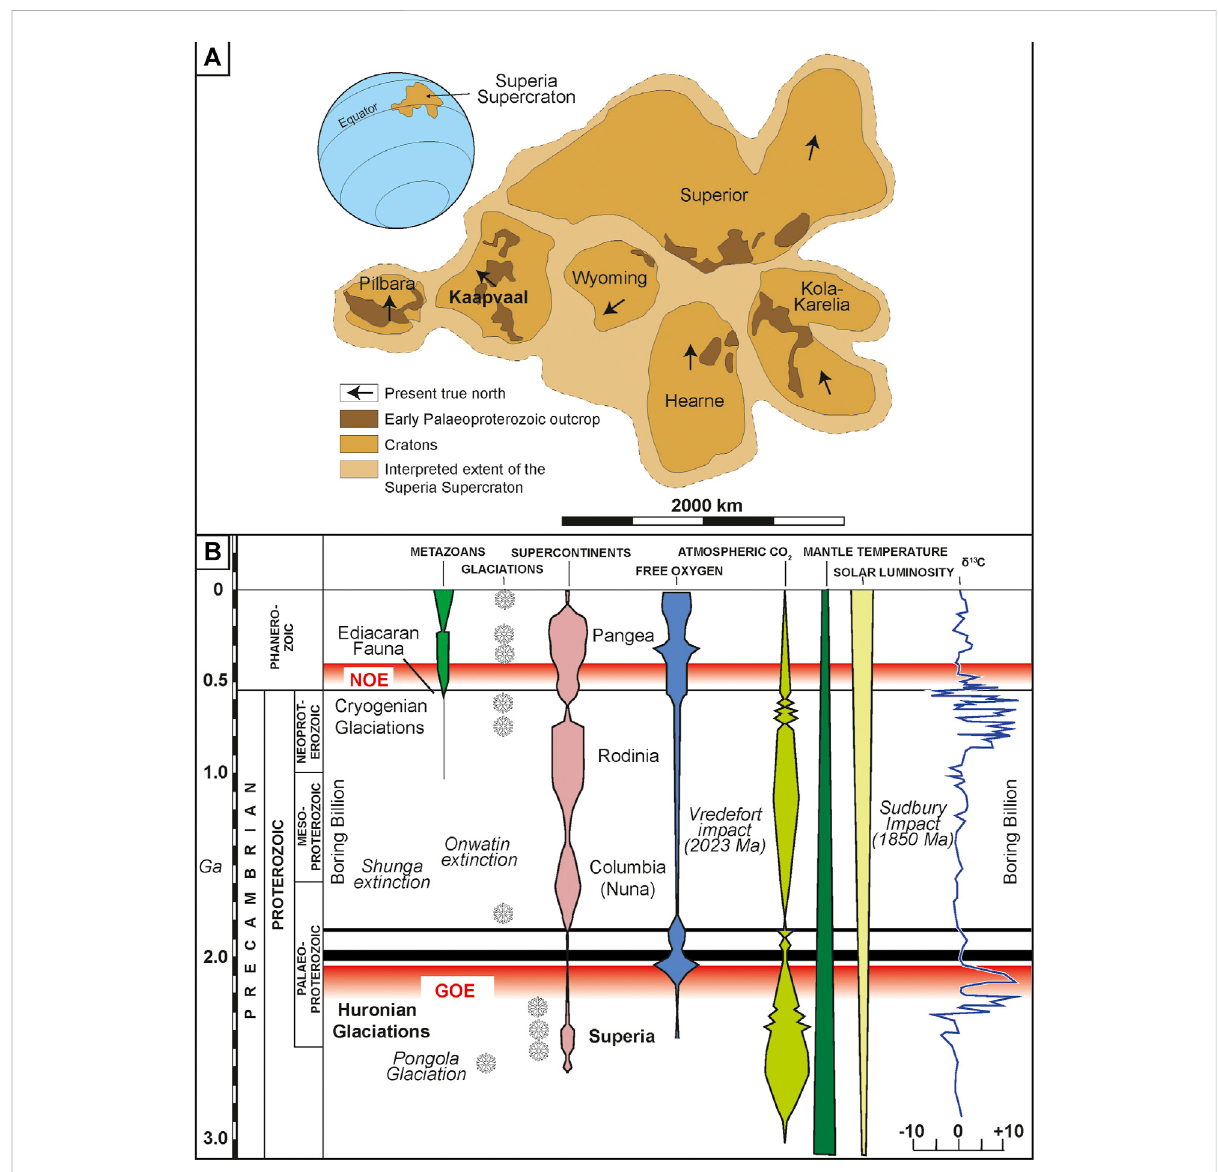
FIGURE 1 (A) : Palaeoproterozoic craton con fi guration and palaeogeography, showing the location of the Kaapvaal Craton within the proposed Supercraton of Superia. Redrawn and simpli fi ed after Gumsley et al. (2017). (B) : Timeline of events throughout the Proterozoic, including the Huronian glaciations of the Siderian (Palaeoproterozoic). Redrawn and slightly modi fi ed from Young